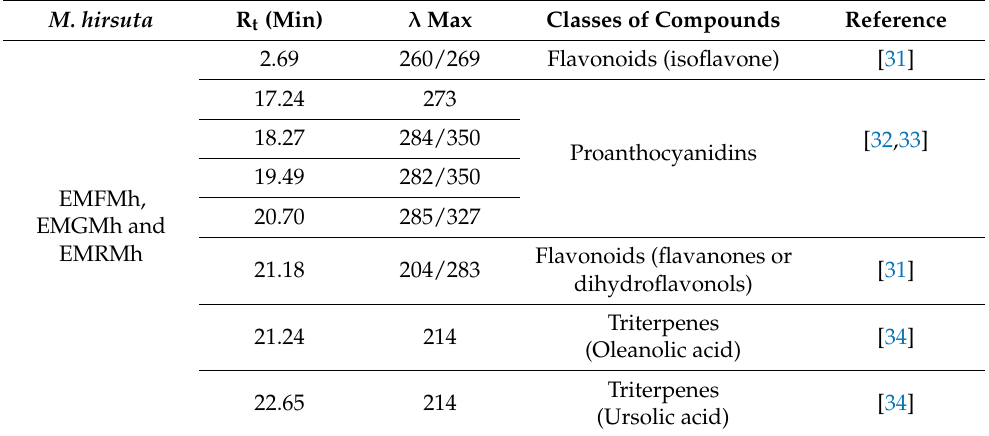
Table 2. Identification by HPLC-PDA of compounds from M. hirsuta extracts UV-Visible Absorptions.